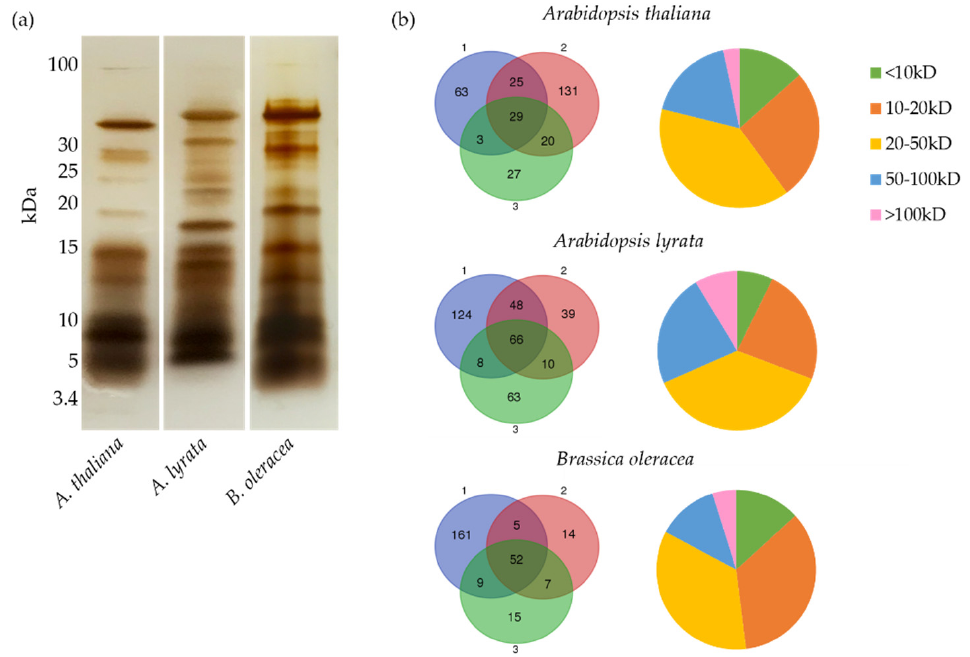
Figure 1. Characterisation of pollen coat protein profiles of Arabidopsis thaliana , Arabidopsis lyrata , and Brassica oleracea . ( a ) Verification of pollen coat protein extracts from A. thaliana , A. lyrata , and B. oleracea . A total of 5% of the total extraction from each preparation was subjected to separation by sodium dodecyl sulphate-polyacrylamide gel electrophoresis (SDS-PAGE), followed by silver staining. ( b ) Overlap of proteins identified in the three replicates ( left panel ) and distribution of protein sizes in each pollen coat gained from three merged proteomic datasets for each species ( right panel ).